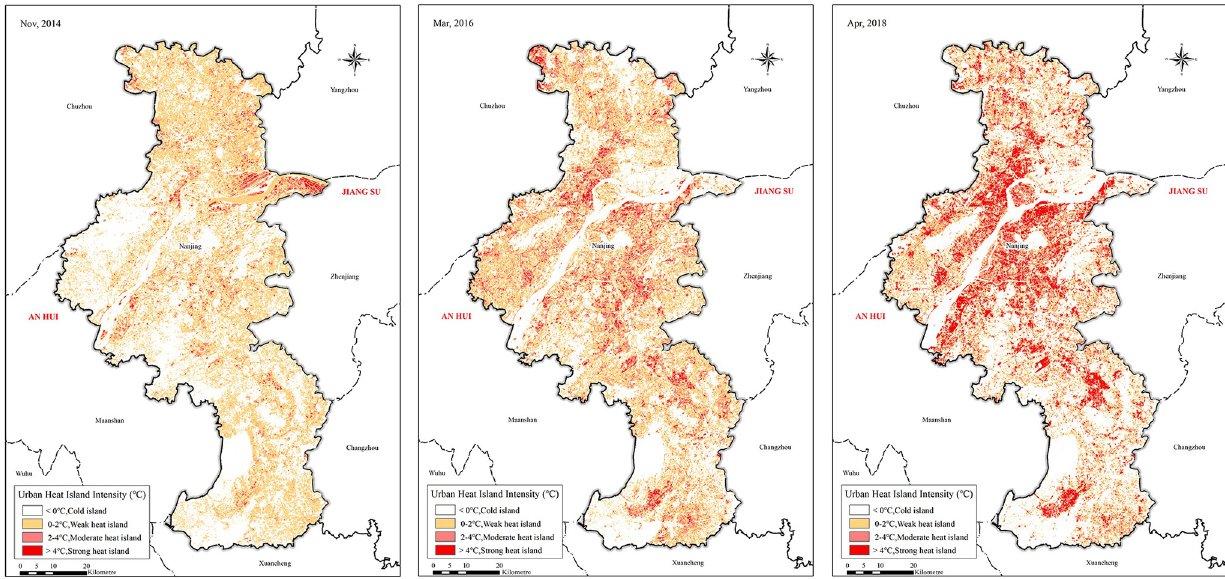
Fig 3. A spatial distribution map of heat island intensity in Nanjing in 2014 (a), 2016 (b), 2018 (c).